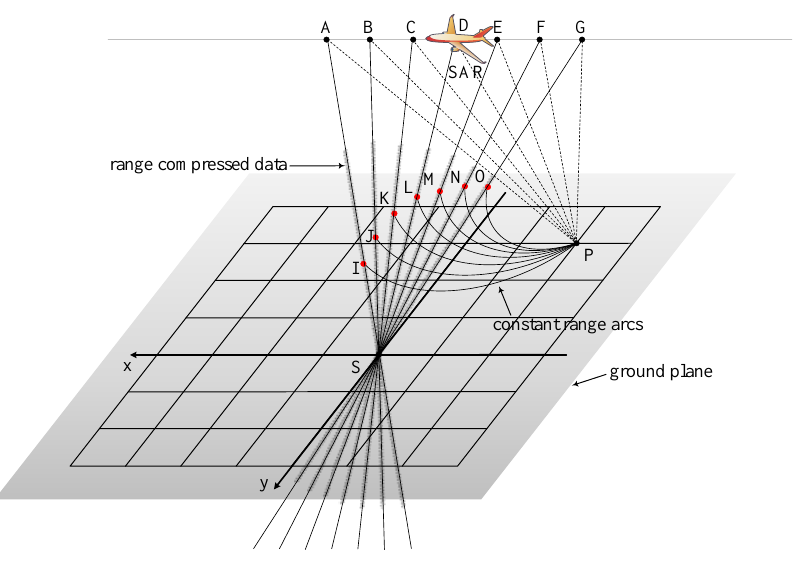
Figure 2. The schematic diagram of BPA.